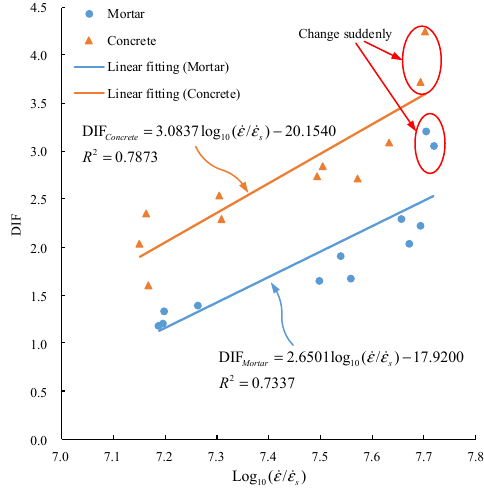
Figure 8. Variation of DIF with logarithm of strain rate.